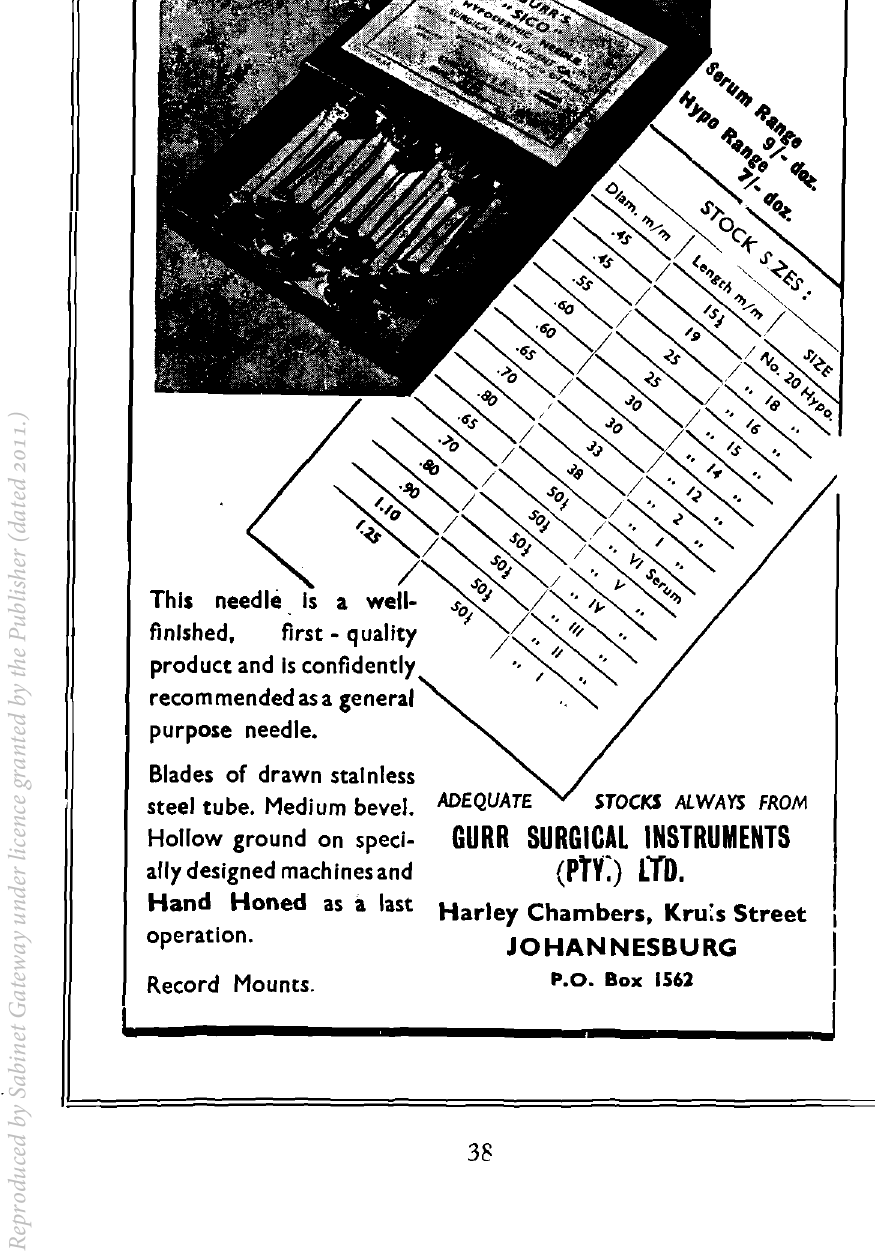
Blades of drawn stainless steel tube. Medium bevel. ADEQUATE STOCKS ALWAYS FROM Hollow ground on sped- GURR SURGICAL INSTRUMENTS ally designed machines and (plY:) LID. Hand Honed as a last Harley Chambers, Kru:s Street I operation. JOHANNESBURG Record